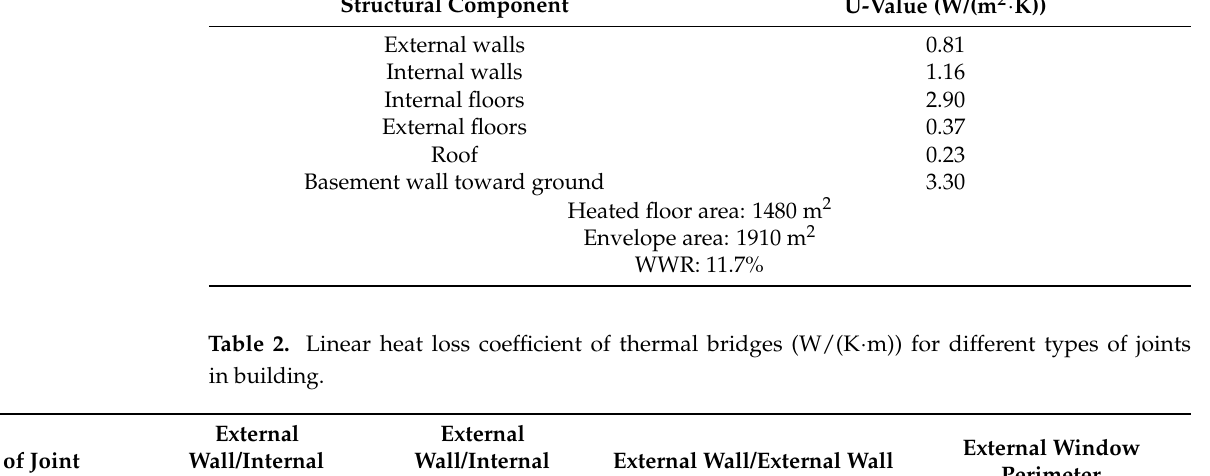
Figure 2. Side view of southwest part of modeled building. Table 1. Thermal transmittance of building’s structural components. Table 2. Linear heat loss coefficient of thermal bridges (W/(K ∙ m)) for different types of joints in building.